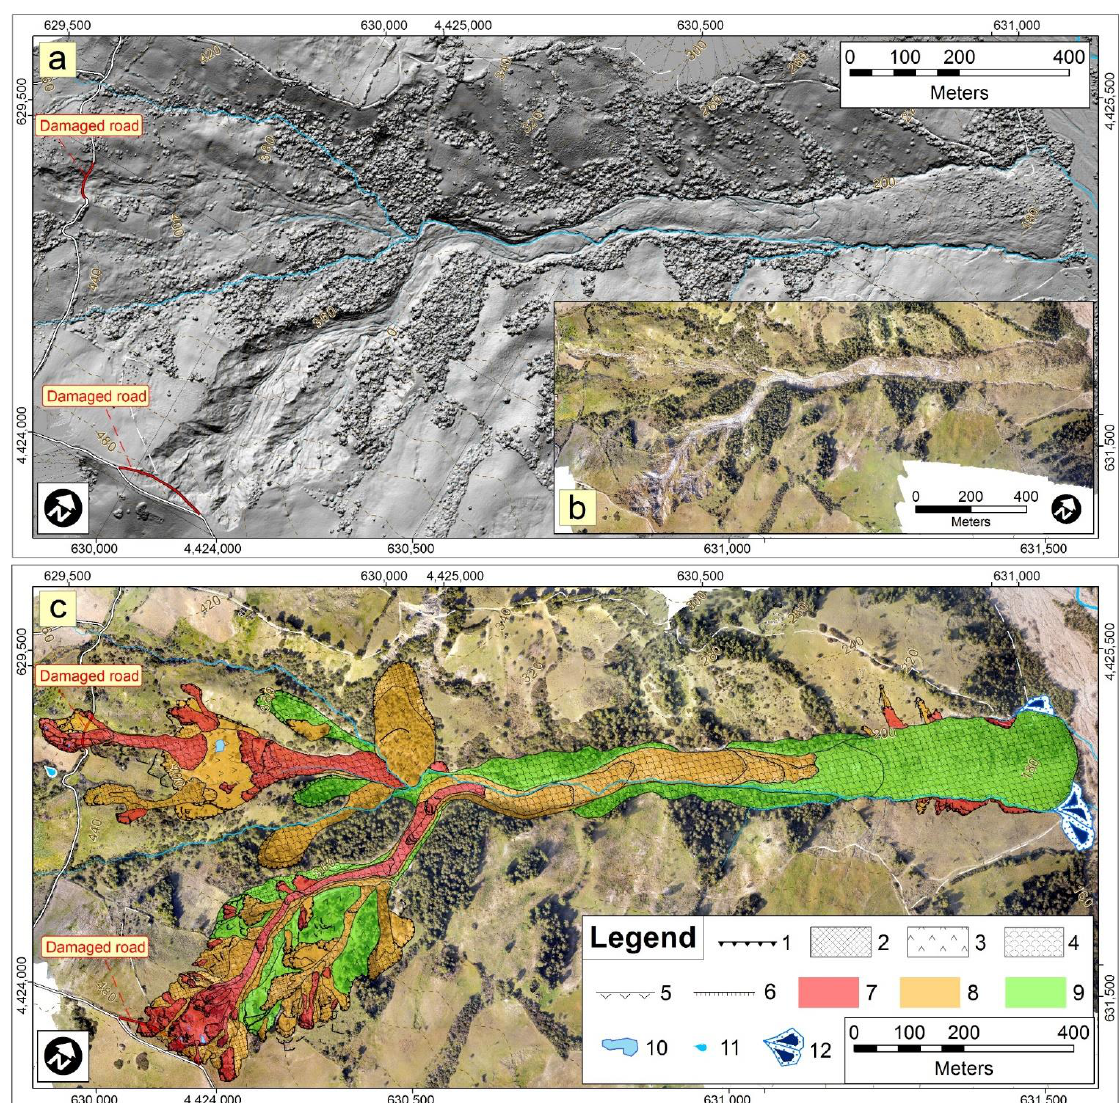
Figure 4. ( a ) Hillshade DSM, ( b ) orthophoto generated through the February 2019 UAV flight, and ( c ) Vomice earthflow map (update April 2019): (1) landslide crown, (2) landslide scarp, (3) slide, (4) flow, (5) toe, (6) secondary scarp, (7) active landslide body, (8) suspended landslide body, (9) dormant body, (10) ponds, (11) spring, (12) fan.